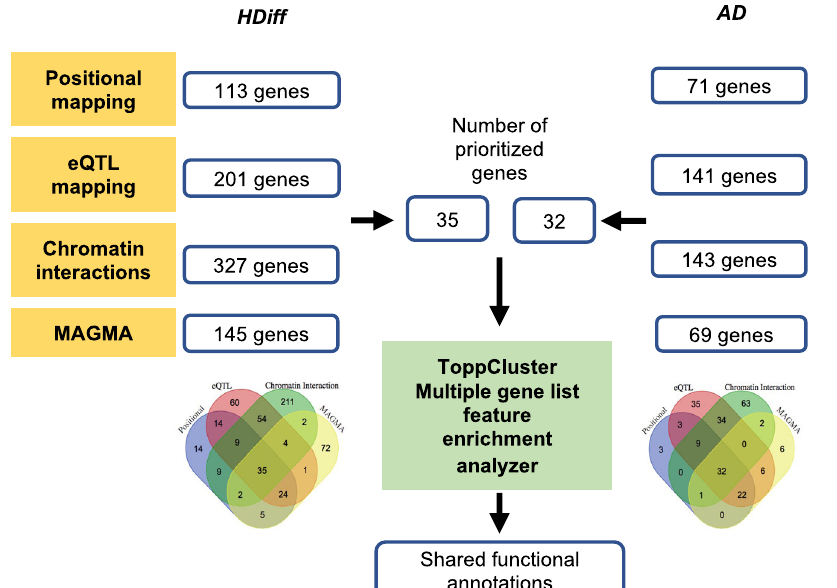
Fig. 4 Flow chart for the gene mapping, prioritization, and gene set enrichment analysis. Gene lists of FUMA outputs based on position, eQTL, chromatin interactions, and a gene-based associations (MAGMA) analysis were all compared using Venn diagram for HDiff and AD each. The Gene set enrichment analysis of the prioritized genes in HDiff and AD was done using ToppCluster tool producing a list of shared functional enrichment